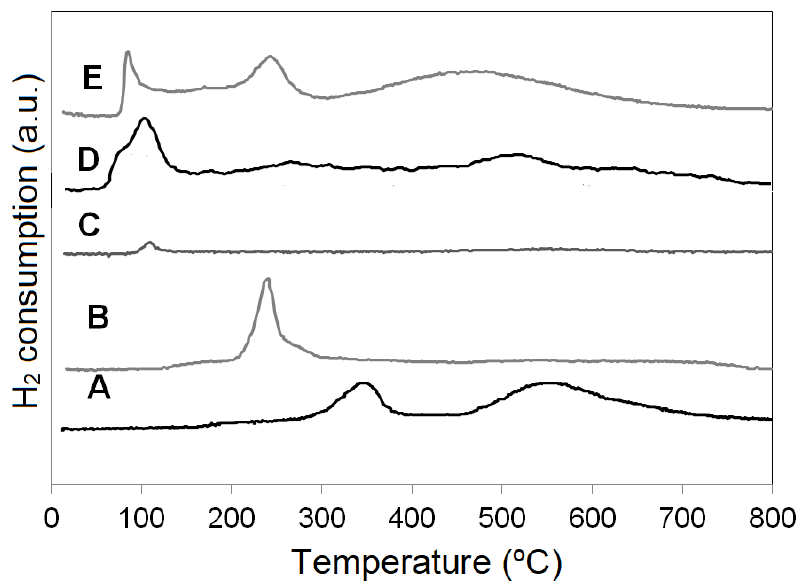
Figure 2. TPR profiles of catalysts. (A) Co-ZnAl; (B) Cu-ZnAl; (C) Pd-ZnAl; (D) PdCu-ZnAl; (E) PdCo-ZnAl.